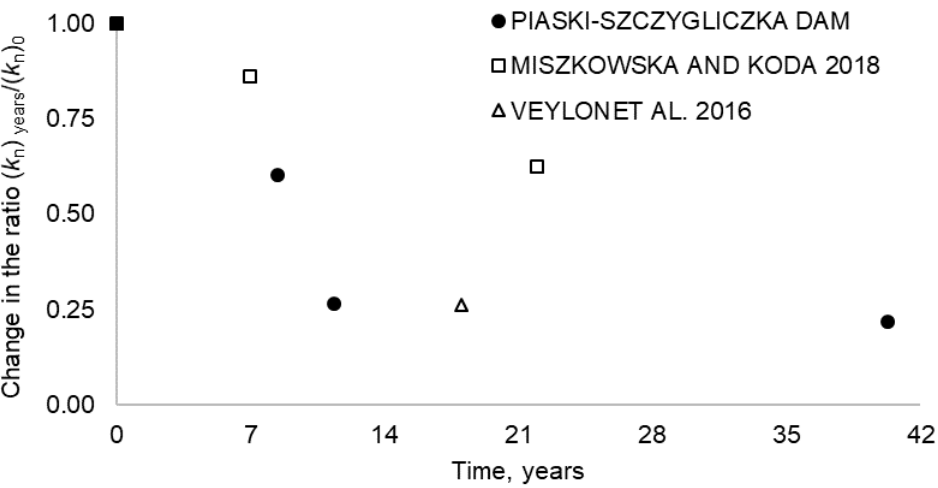
Figure 10. Changes in coefficient permeability ratio ( k n ) years /( k n ) 0 over the years.